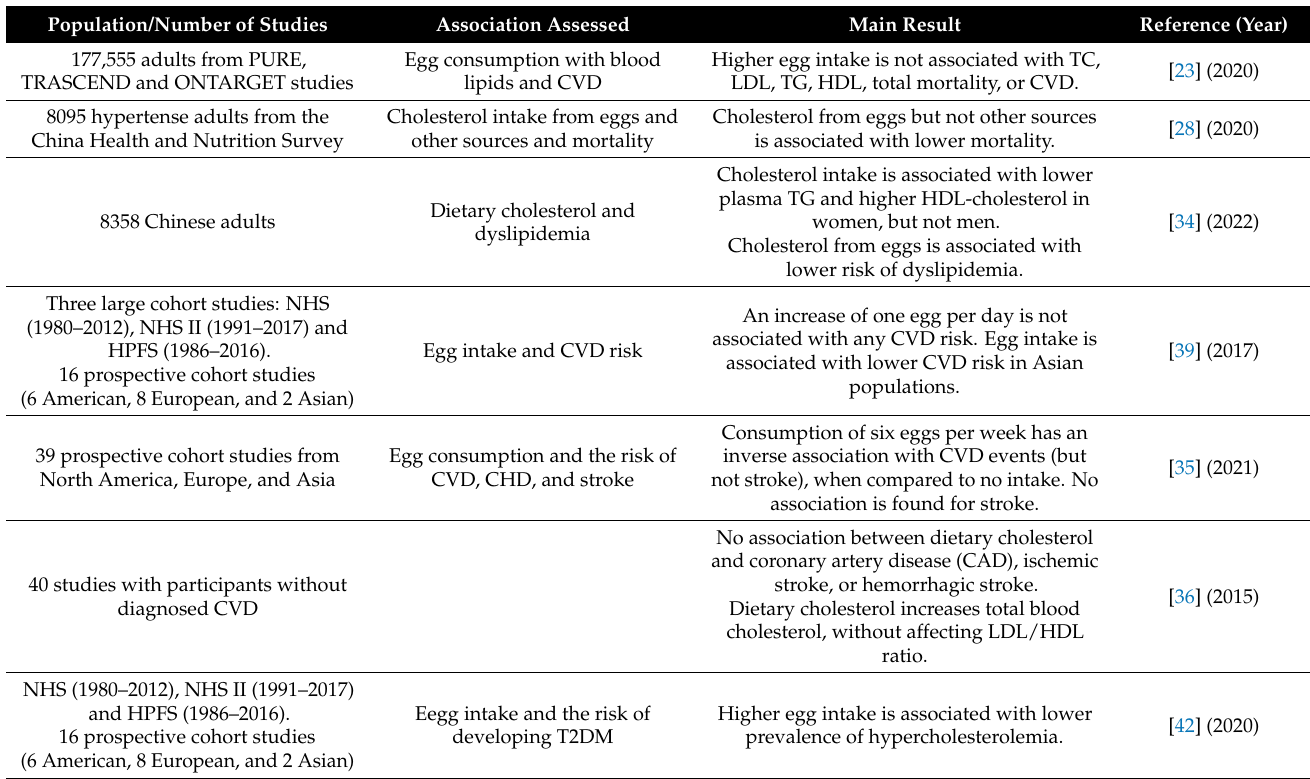
Table 1. Results from recent epidemiological studies and meta-analysis showing the lack of correlation between dietary cholesterol and blood